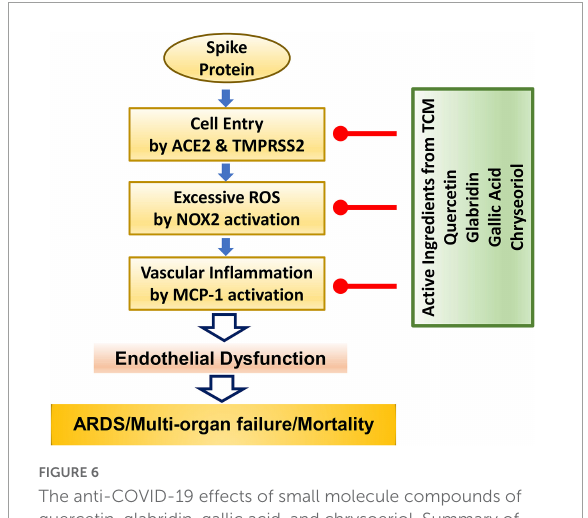
FIGURE6 The anti-COVID-19 effects of small molecule compounds of quercetin, glabridin, gallic acid, and chrysoeriol. Summary of therapeutic actions of active small molecules in protecting against S protein-induced endothelial dysfunction and inflammation to result in attenuation of ARDS/multi-organ failure and mortality in patients with